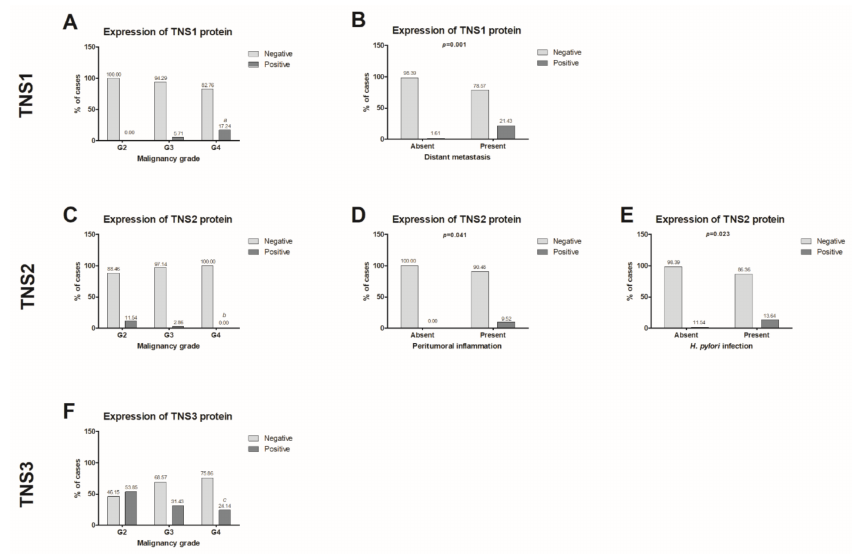
Figure 2. Comparison of TNS1-3 expression levels with the selected clinicopathological parameters: ( A ) TNS1 and malignancy grade, G2 vs. G4 statistically significant at p = 0.02; ( B ) TNS1 and distant metastasis; ( C ) TNS2 and malignancy grade, G2 vs. G4 statistically significant at p = 0.045; ( D ) TNS2 and peritumoral inflammation; ( E ) TNS2 and H. pylori infection; ( F ) TNS3 and malignancy grade, G2 vs. G4 statistically significant at p = 0.025. The comparison of TNS1-3 expressions with the selected clinicopathological parameters was performed using the Mann-Whitney U test for two groups, and the Kruskal-Wallis test for 3 and more groups. Dunn’s Multiple Comparison post hoc test was applied for Kruskal-Wallis test. A value of p < 0.05 was considered statistically significant. a , b , c p < 0.05 G2 vs. G4 TNS1-3 expression levels in gastric cancer. G2—moderately differentiated GC, G3—poorly differentiated GC, G4—non-differentiated